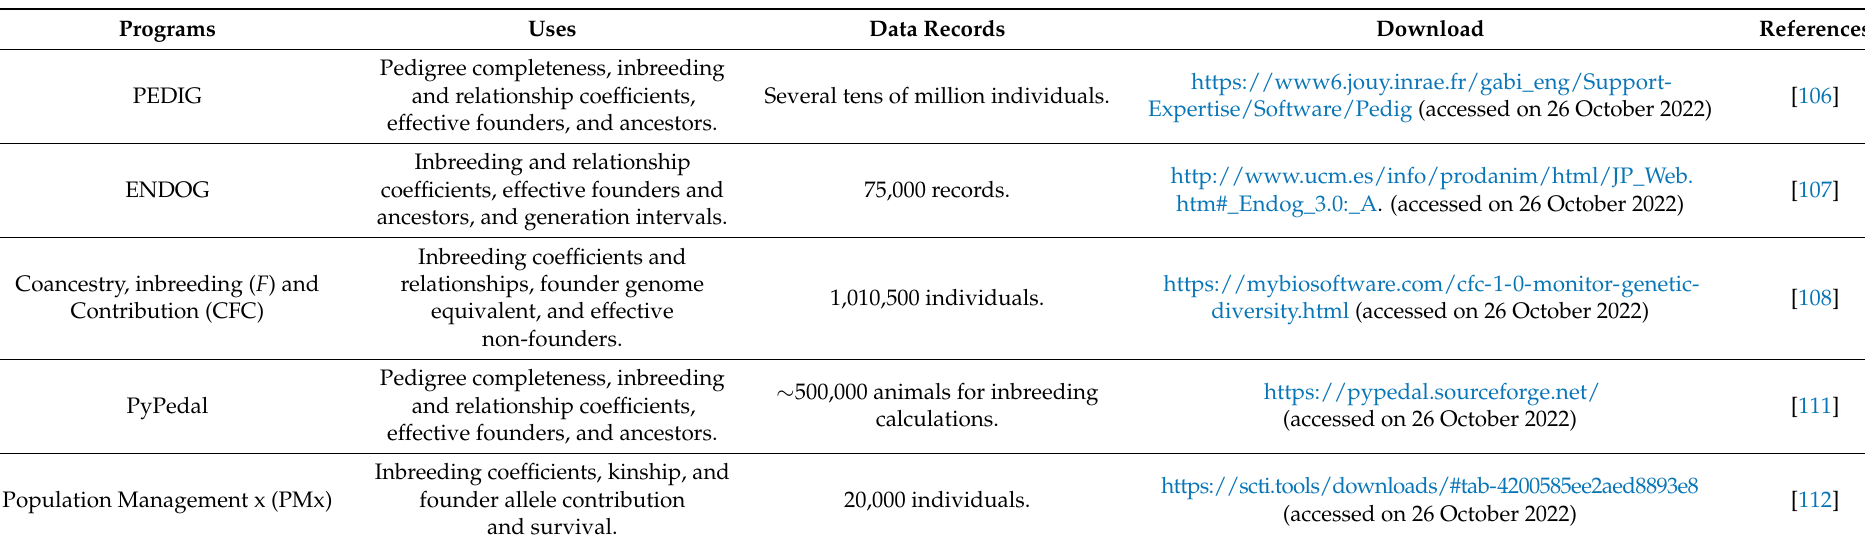
Table 2. Programs used to measure genetic diversity in pedigree